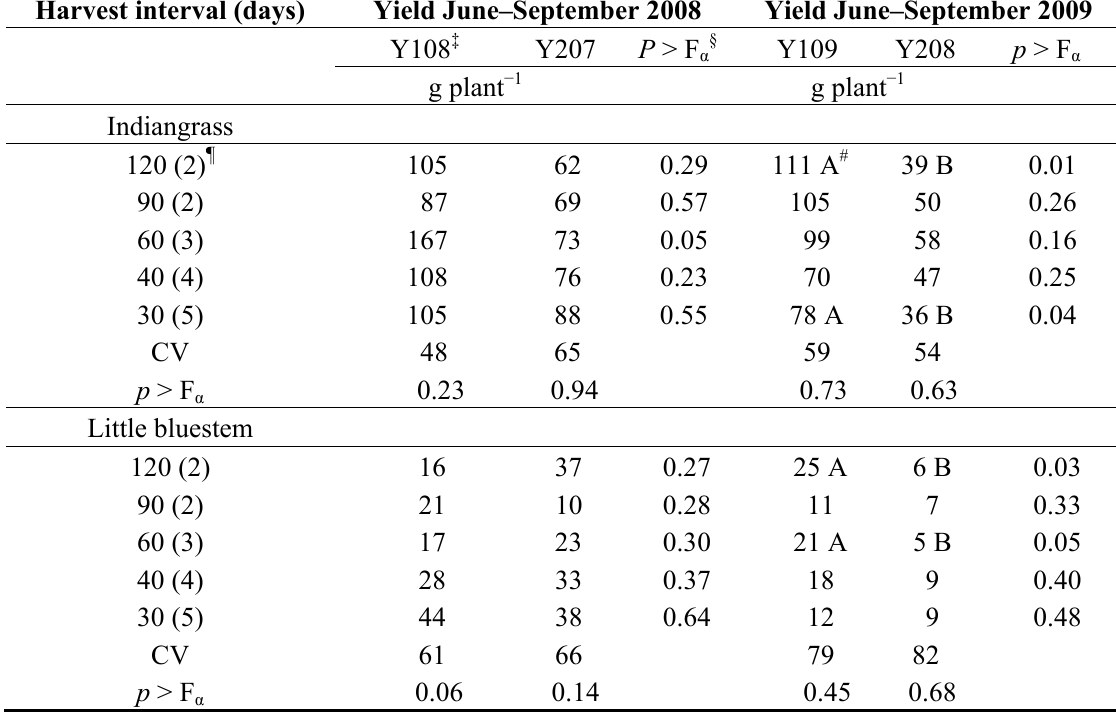
Table 1. Effects of harvest interval and harvest-duration on cumulative (June–Sep.) yield by indiangrass ( Sorghastrum nutans ) and little bluestem ( Schizachyrium scoparium ) in mixed native grass stands † at their first and second harvest-year in two consecutive